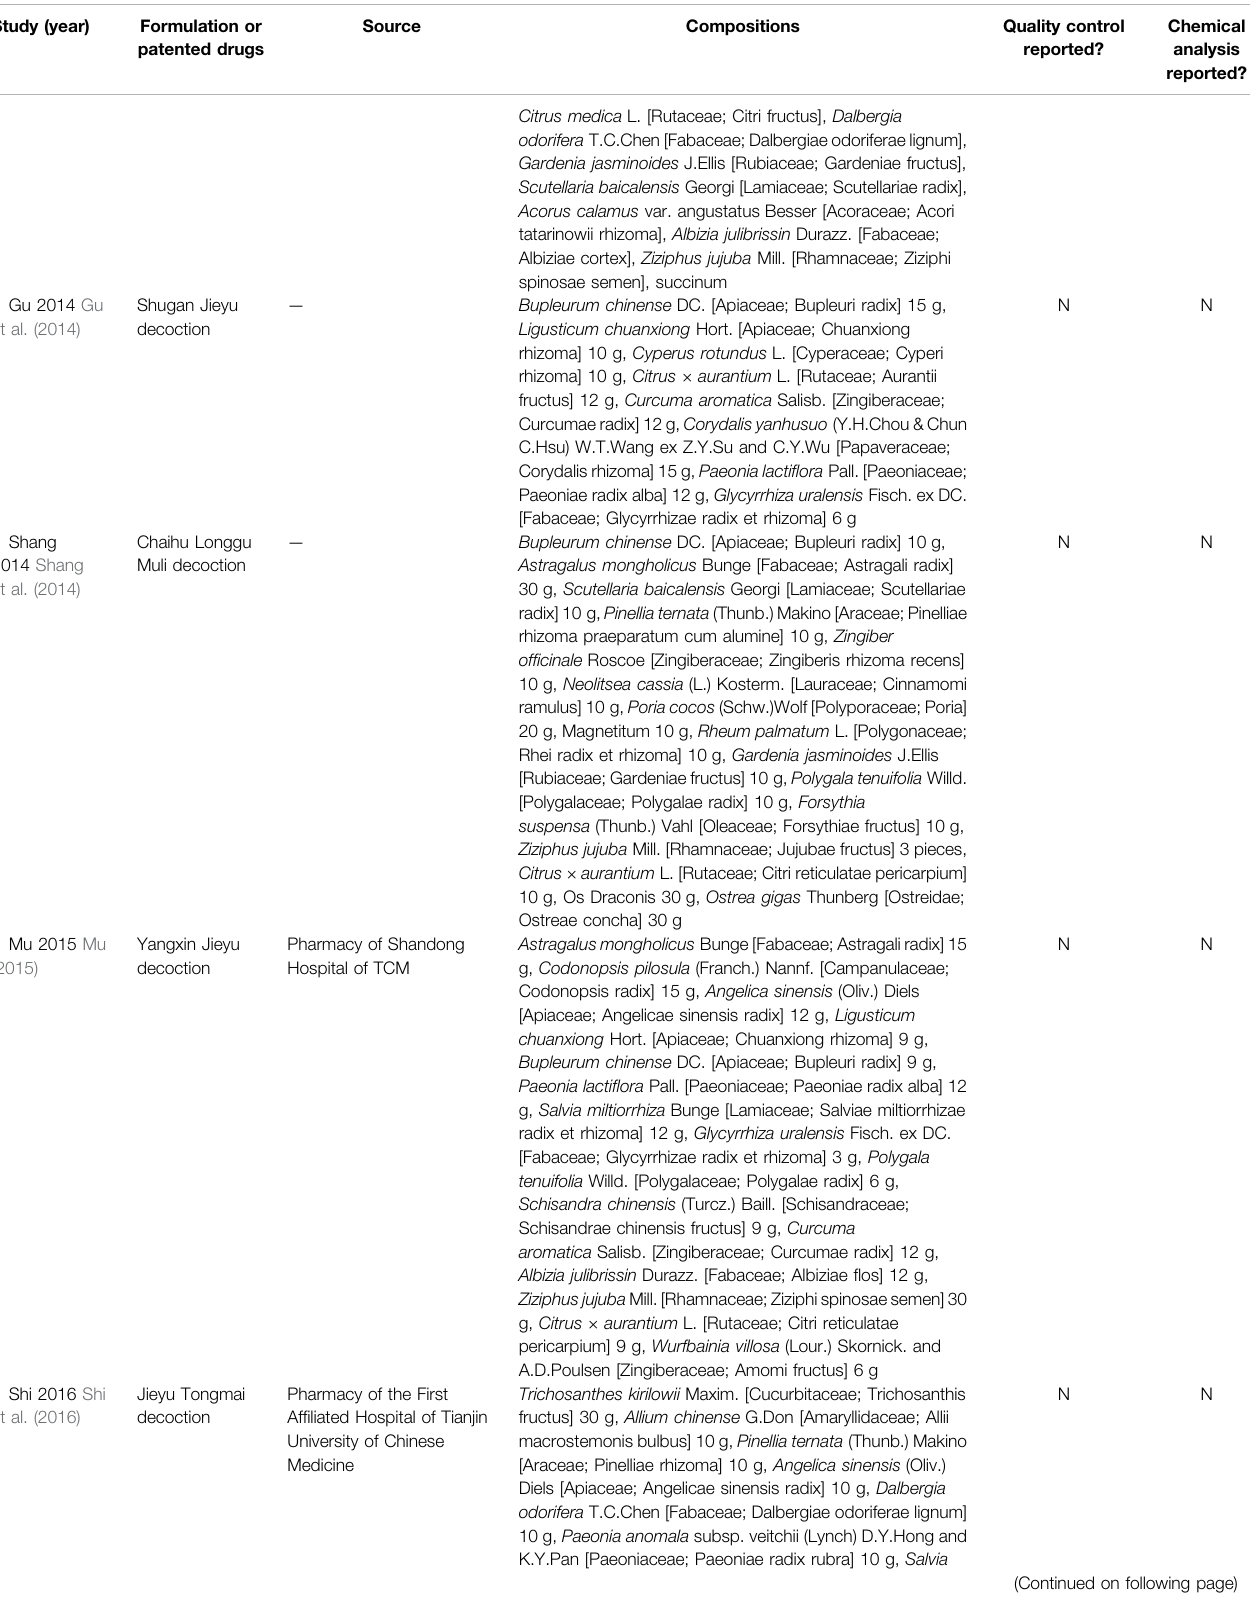
TABLE 1 | ( Continued ) Compositions of formulation and patented